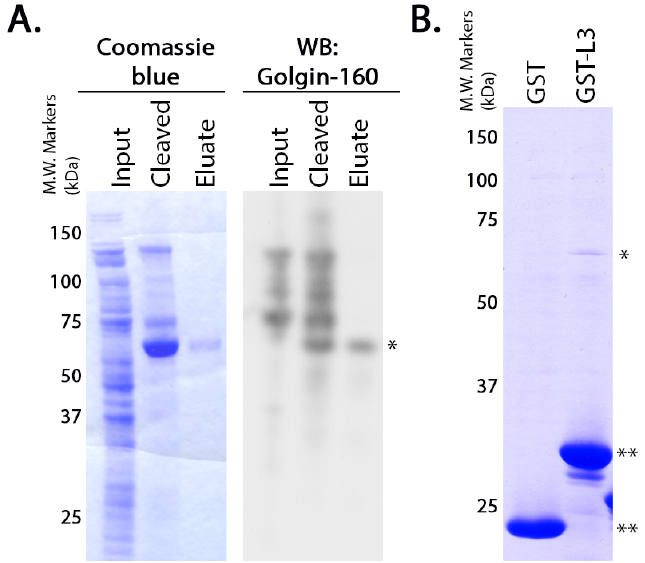
Figure 1. Beta-1 adrenergic receptor ( β 1AR) binds directly to golgin-160 . (1–393) and its binding to β 1AR are Representative gels for the purification of golgin-160 (1–393) shown. ( A ) The NEB IMPACT system was used to create a purified, untagged golgin-160 following cleavage of the intein tag. DTT-induced cleavage caused (1–393) enrichment of an approximately 60 kDa protein, which was specifically eluted off of the chitin column. This protein band could be detected using immunoblotting with an antibody to the N-terminus of golgin-160. Input, protein added to the chitin column; Cleaved, protein on the chitin column after addition of DTT but before elution; Eluate, protein released from the column after cleavage; *, golgin-160 ; **, GST fusion proteins; ( B ) The purified, (1–393) untagged golgin-160 head domain was incubated with purified GST or GST- β 1AR L3 pre-bound to glutathione-Sepharose 4B beads. The beads were washed and bound golgin-160 was detected by Coomassie blue staining after SDS-PAGE. Note that the (1–393) samples in panel A were run on a 4%–12% gradient gel, whereas those in B were run on a 10%